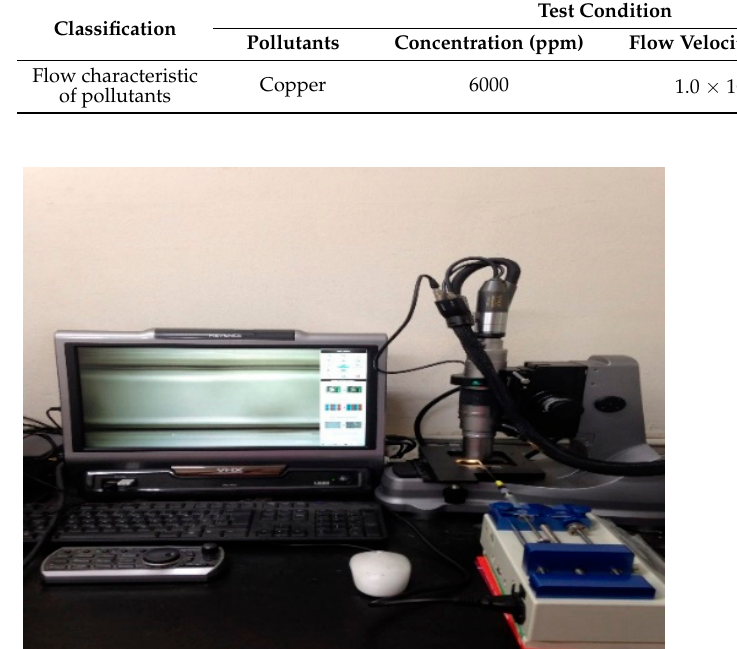
Figure 1. Test equipment.